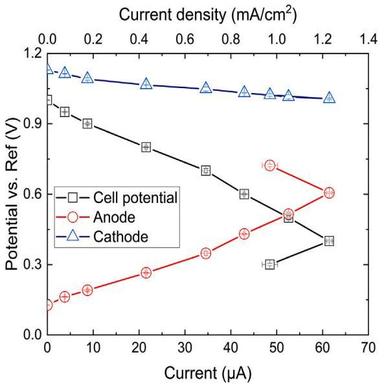
MFC polarization curve. Each point is an average of the recorded data for one minute.